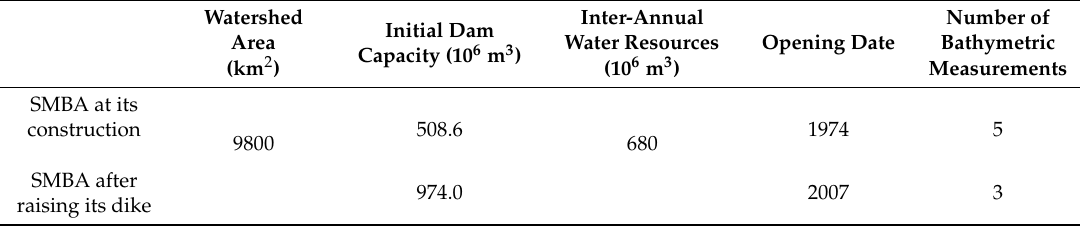
Table 1. Sidi Mohamed Ben Abdellah (SMBA)dam data.